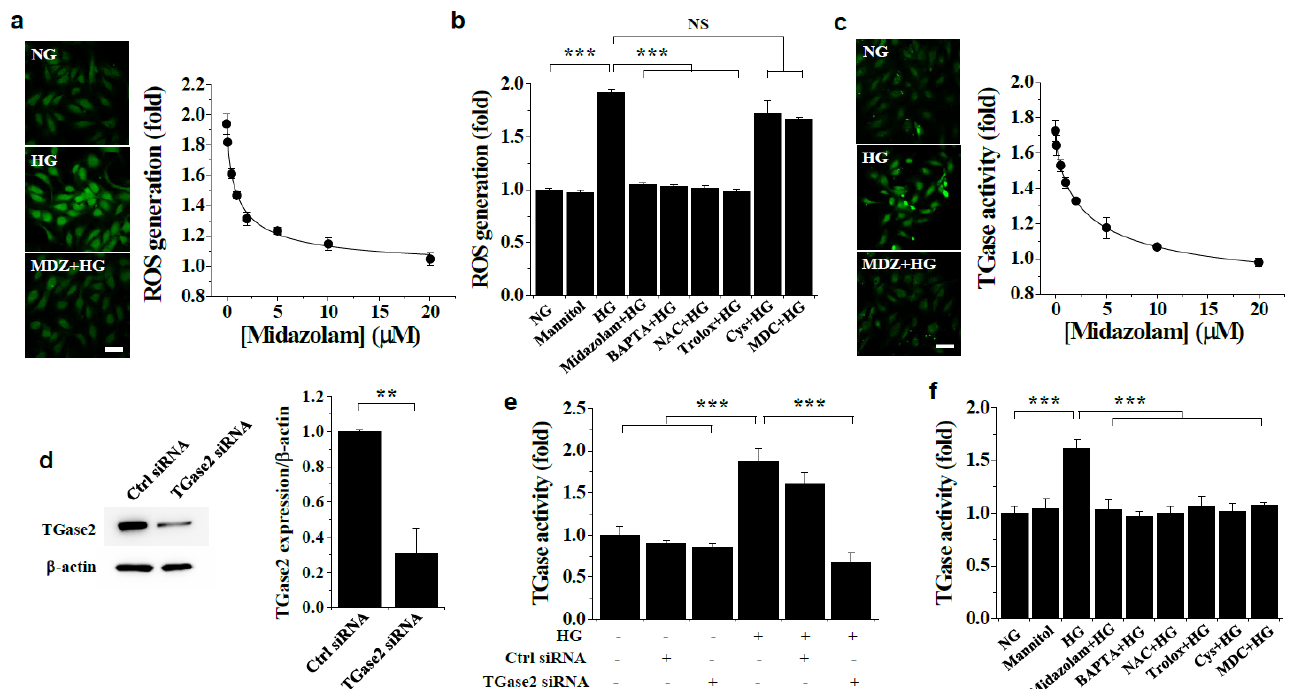
Figure 4. Effects of midazolam and inhibitors on high glucose-induced generation of reactive oxygen species (ROS) and TGase2 activation in HGECs. HGECs were treated for 3 days with normal glucose (NG) or high glucose (HG) at the indicated concentrations of midazolam (MDZ) or in the presence of 20 µ mol/L MDZ, 5 µ mol/L BAPTA-AM, 1 mmol/L NAC, 0.5 µ mol/L Trolox, 50 µ mol/L cystamine, 20 µ mol/L MDC, or 100 nM TGase2-specific small interfering (si) RNA or control (Ctrl) siRNA. Mannitol was used as an osmotic control. Intracellular ROS levels ( a , b ) and in situ TGase transamidation activity ( c , e , f ) were visualized by confocal microscopy and quantified by measuring fluorescence intensity. Scale bar, 50 µ m. ( d ): TGase2-specific siRNA inhibits TGase2 expression. Results are expressed as the mean ± SD from three independent experiments. ** p < 0.01, *** p < 0.001; NS,